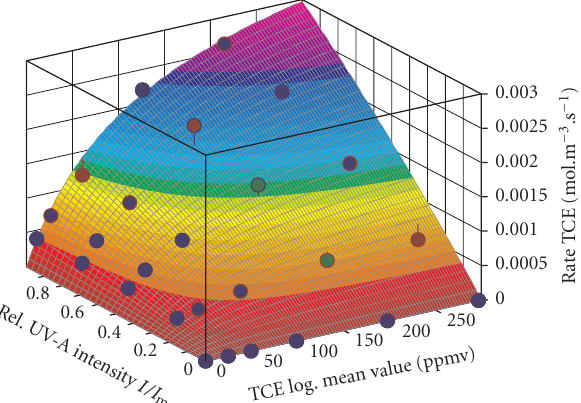
Figure 5: Experimental results (dots) and kinetic fit for the photocatalytic oxidation of TCE on PCAA in dependence of concentration and light